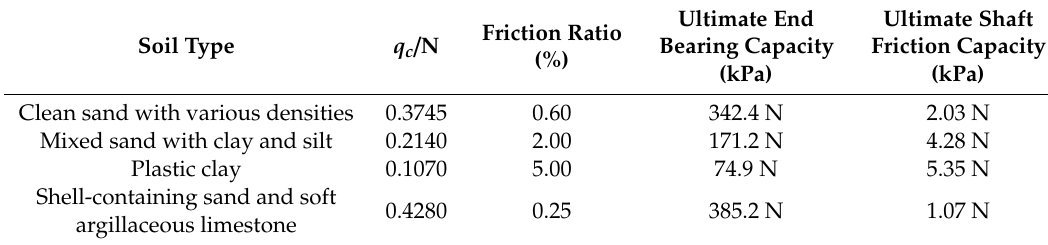
Table 2. Schmertmann